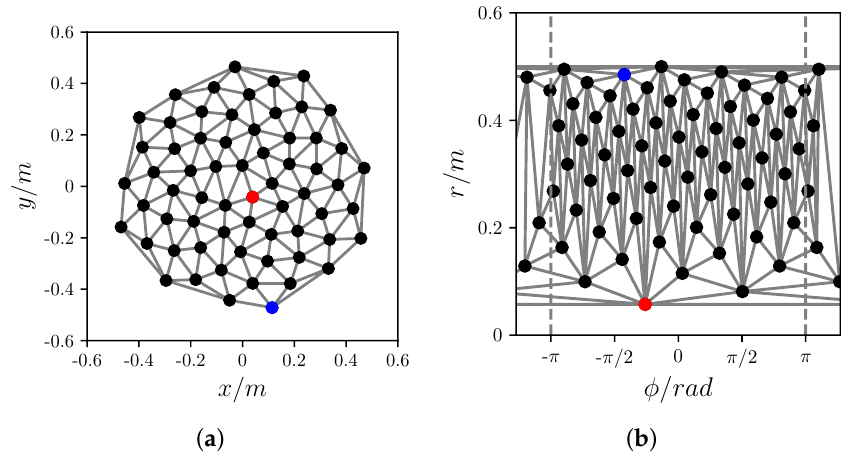
Figure 1. Delaunay triangulation of the geometry in Cartesian coordinates ( a ) and in cylinder coordinates ( b ) with repeating microphone position points in angular direction. The black dots denote the microphone positions, the grey lines indicate the edges of each mesh triangle. The red and blue points indicate transferred microphone